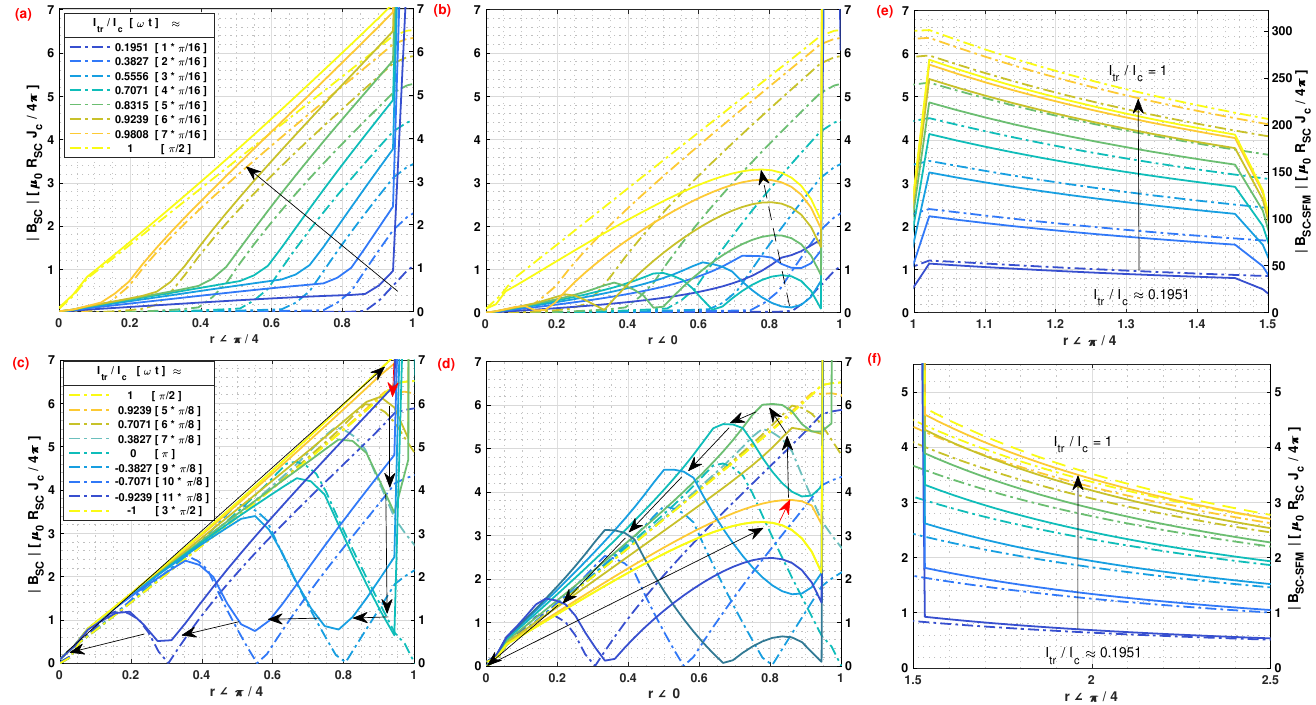
Figure 3. Dynamics of the norm of magnetic flux density over the radial directions ( r , π /4 ) and ( r ,0 ) for different magnitudes of the applied AC transport current, I tr = I c sin ( ω t ) , it measured inside the SC during ( a , b ) the first ramp of the applied current (top legend-box) and ( c , d ) the peak-to-peak hysteretic period (bottom legend-box) as described in Figures 1 and 2. The panel of subplots at the right shows the corresponding profiles for the first ramp of current at ( e ) inside the SFM and ( f ) outside the SC-SFM wire, respectively. Dashed-dot lines at each subplot refer to the left axes | B SC | showing classical Bean’s behaviour, whilst the solid lines must be read accordingly with the right hand axes | B SC − SFM | . The arrows show the ’time’ evolution of the field profiles, and units for B are ( µ 0 /4 π ) J c R SC